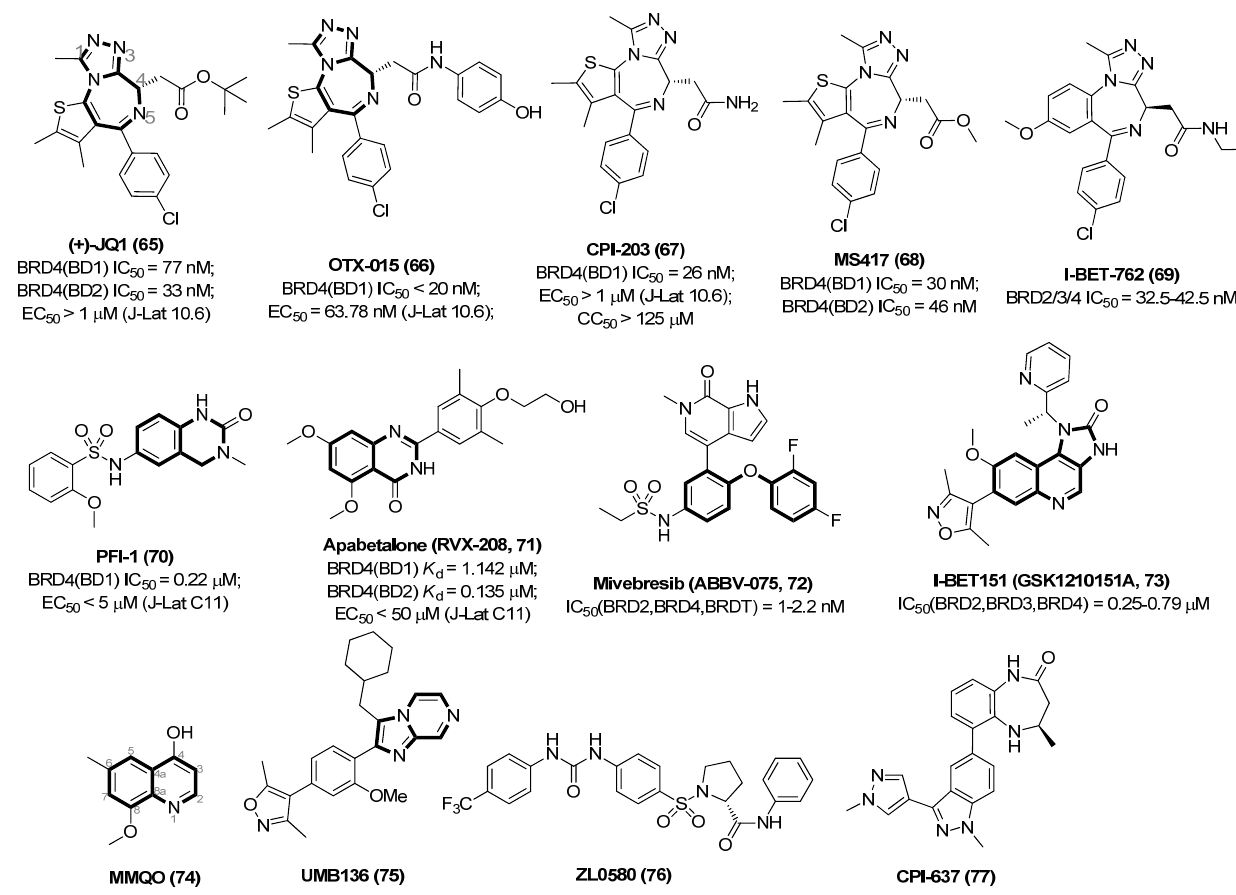
Figure 12. Chemical structures of representative BETIs as LRAs (65~77).